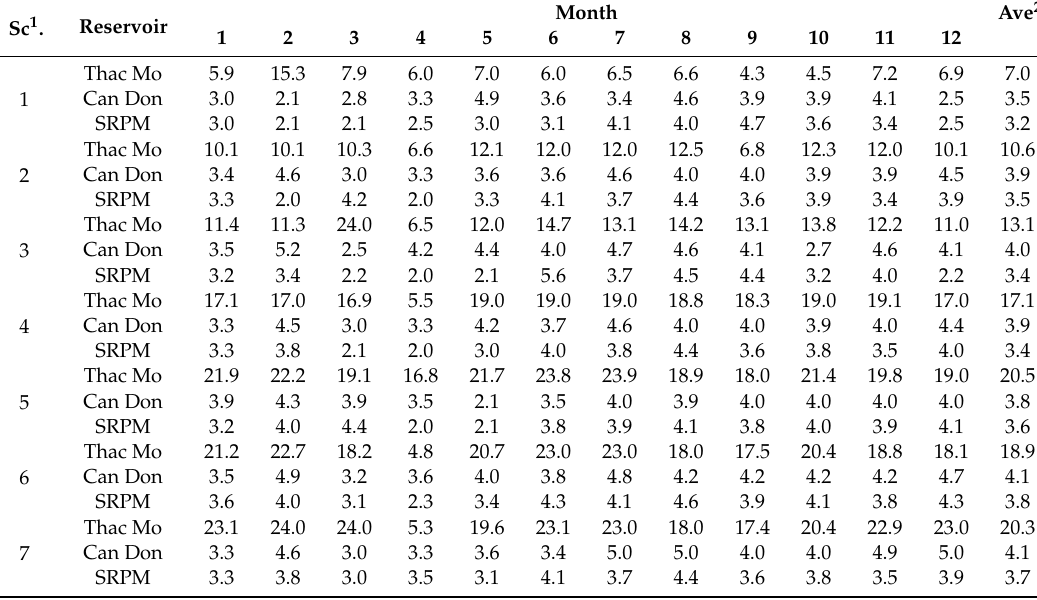
Table 3. Optimized generating hour of di ff erent water shortage scenarios.